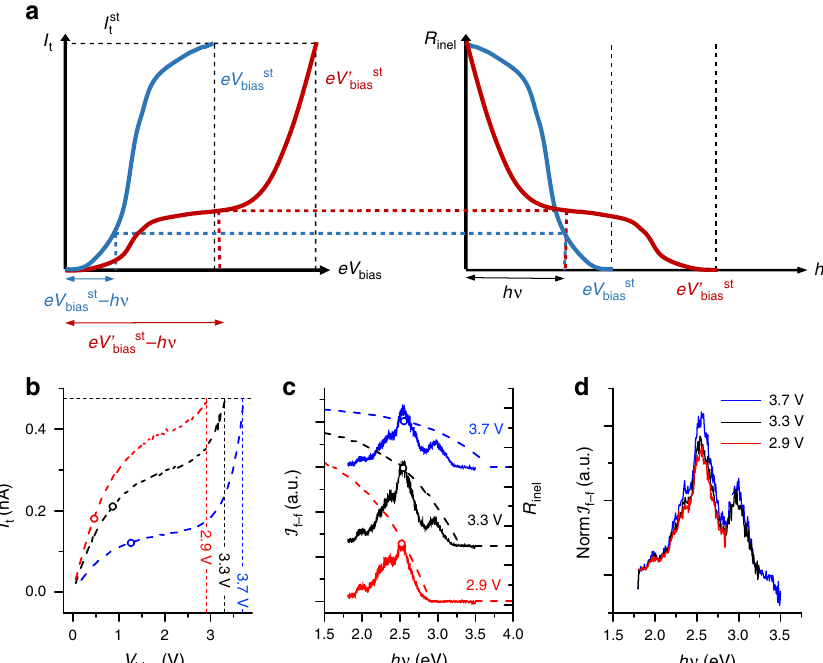
Fig. 4 Example of the normalisation procedure. a Schematic representation of the relationship between the inelastic rate and the tunnelling current in Eq. (4) for two values of the stabilisation bias voltage. The dashed-colour lines represent the contribution to the inelastic rate to the same photon energy for = 0.47nA and bias voltages of 2.9, 3.3 and 3.7 V, respectively, both voltages obtained from the I ( V ) curves. b Experimental I ( V ) curves recorded with I st t measured right before the corresponding lumines c ence spectra. c Luminescence spectra (solid lines) recorded with the same tunnelling parameters as in b and the rate of inelastic events (dashed lines) as given by Eq. (4). The solid c ircles in b and c correspond to the tunnelling intensities (and thus inelastic rates) at the voltages that correspond to the photon energy of 2.55 eV (dipolar contribution). d Normalised luminescence spectra.